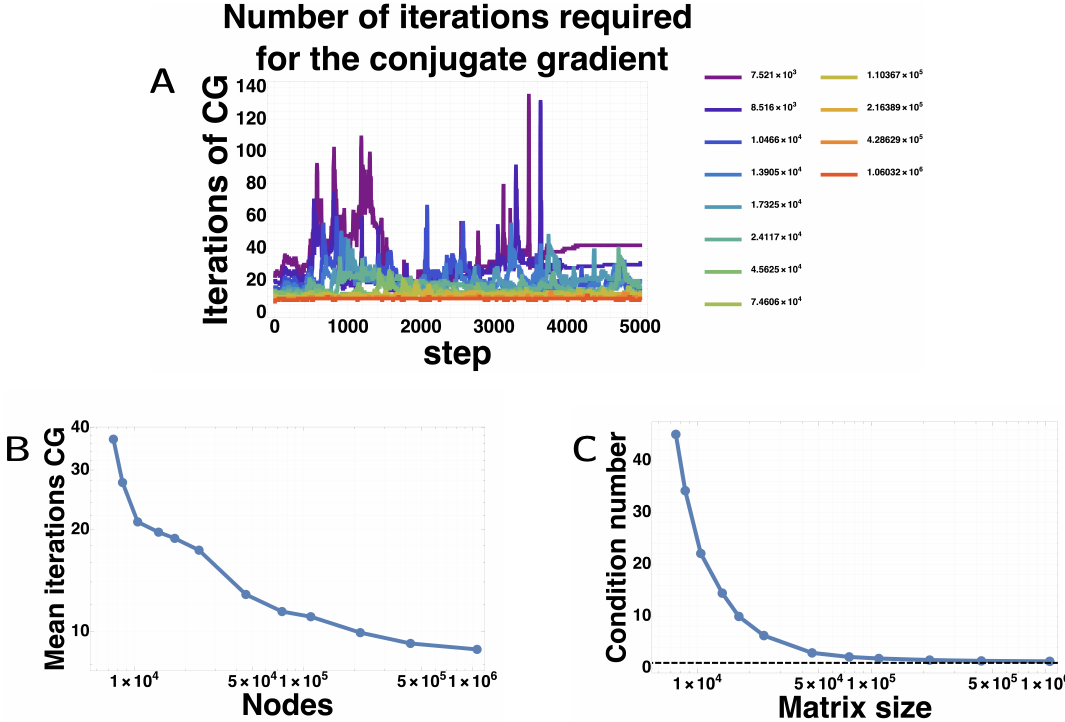
Figure 5. Numerical difficulty of the Conjugate Gradient Method. ( A ) Number of iterations required by the CGM to reach convergence (relative error of the residual decreases below 0.001) for different matrix sizes; ( B ) Mean number of iterations of the CGM extracted from ( A ); ( C ) condition number of the matrix ( D + τ S ) according to the matrix size. The dashed line shows the value of 1, which is the absolute minimum for a condition number. The condition number of the matrix was taken by multiplying the L 2 norm of the matrix and its inverse, each estimated on random vectors of norm